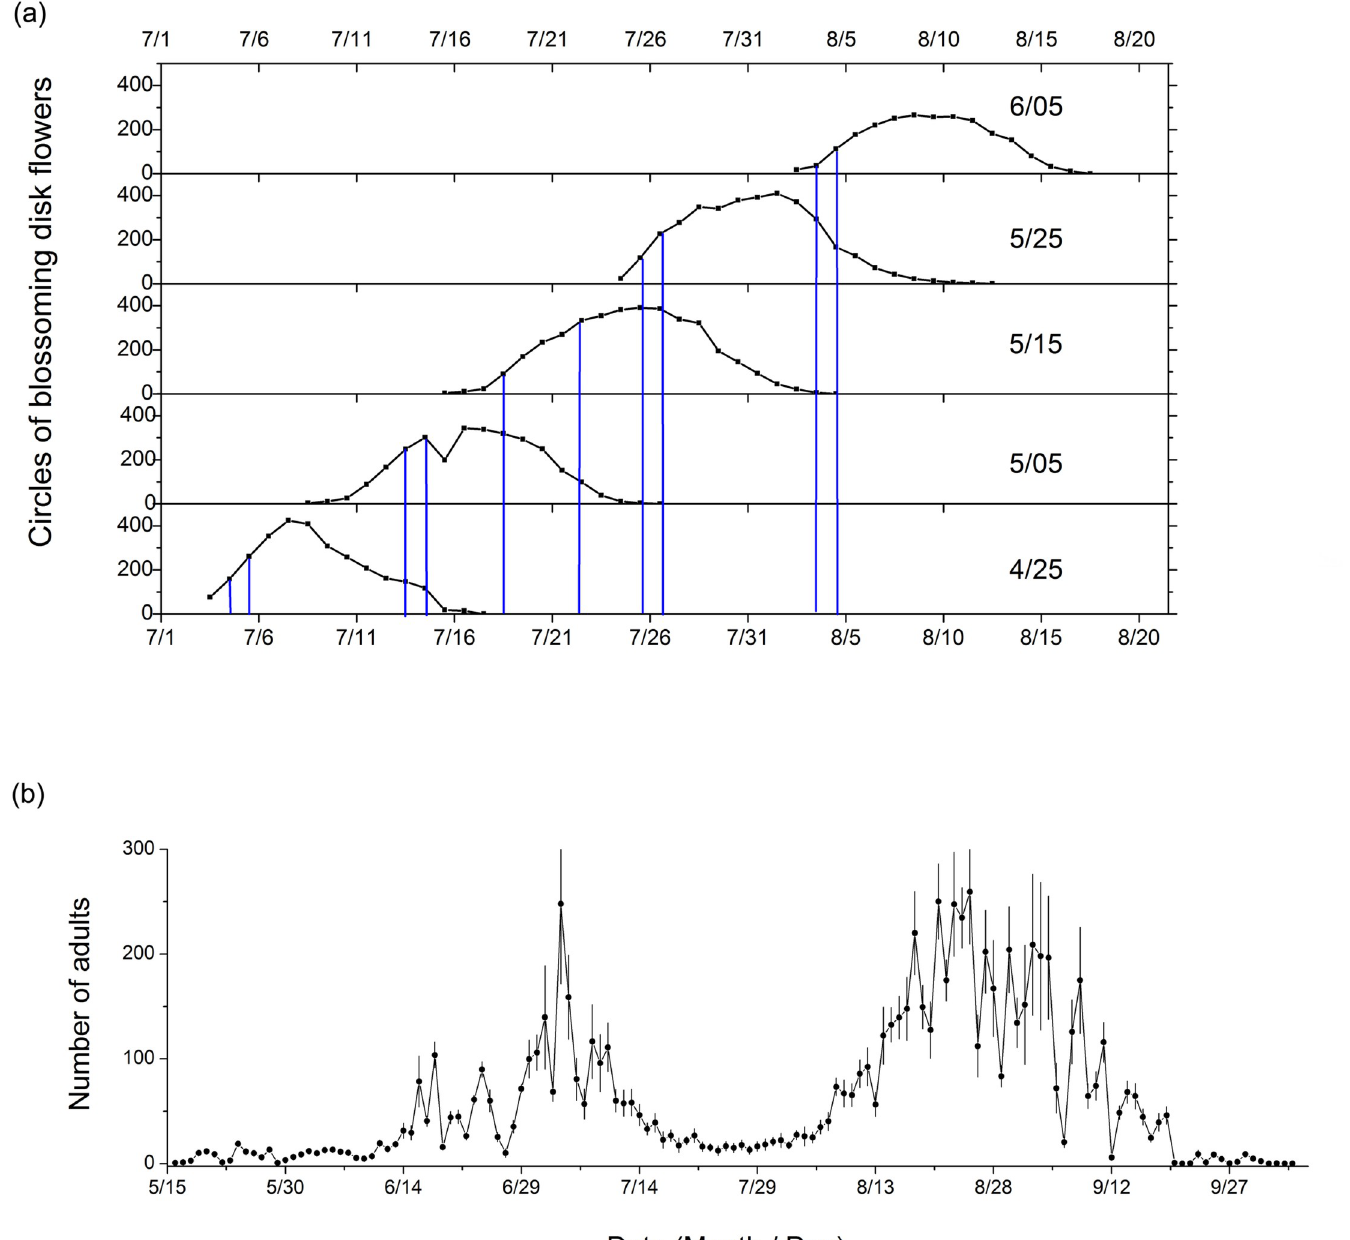
Fig 2. Adult H . nebulellum occurrence measured by pheromone trapping, and flowering of sunflower in Bayannur, China, in 2013. (a) Temporal overlap between flowering period of sunflowers planted on different dates and occurrence peak of adult H . nebulellum . Blue lines pairs demarcate day from first flowering to the day when 50% of plants entered the first or second day of flowering for each planting date group. The number of circles of blossoming disk flowers was the sum of 60 sampled plants. (b) Mean ( ± SEM, n = 4) number of adult male H . nebulellum captured by pheromone traps.